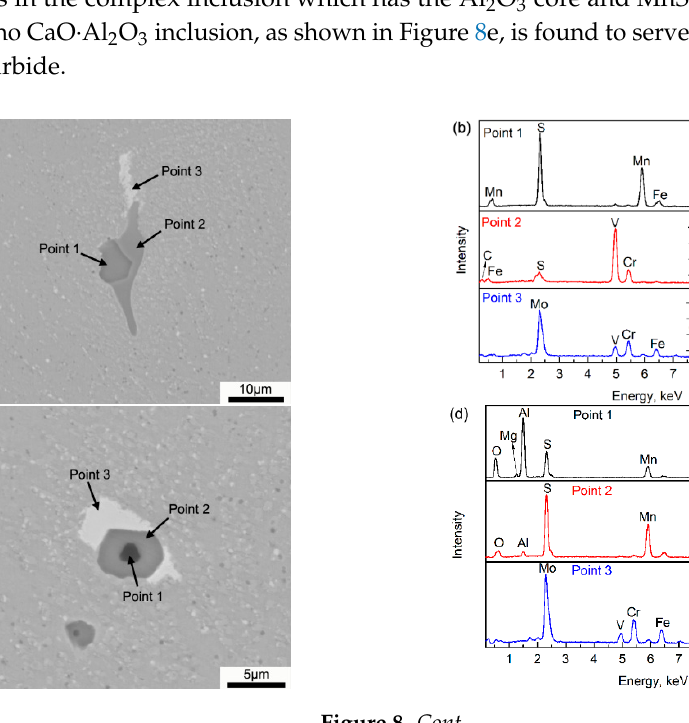
Table 3. Disregistry between the studied phases.